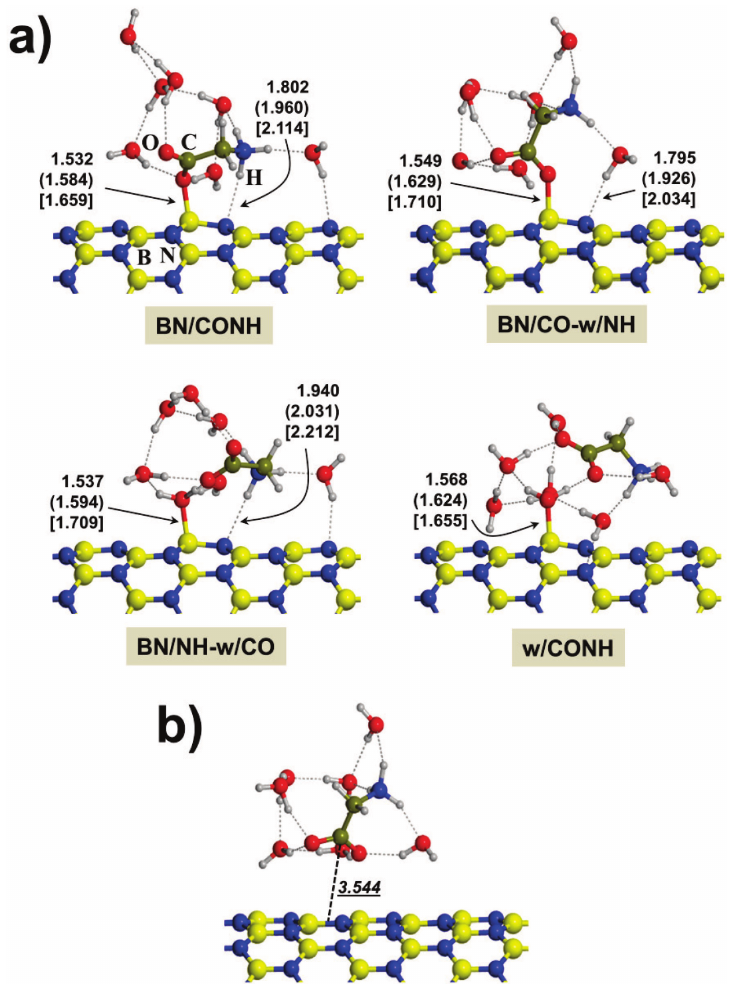
Figure 2. B3LYP-D2* optimized structures of the different calculated complexes for glycine interacting with the (4,0), (6,0) and (9,0) BNNTs ( a ) and with the (15,0) BNNT ( b ) in the presence of seven water molecules. Distances in Å: bare values for the (4,0) BNNT; values in parenthesis for the (6,0) one; values in brackets for the (9,0) one; and italic underscored values for the (15,0) one. For this latter case, the distance is that between the C atom and the plane defined by the closest B-N hexagon